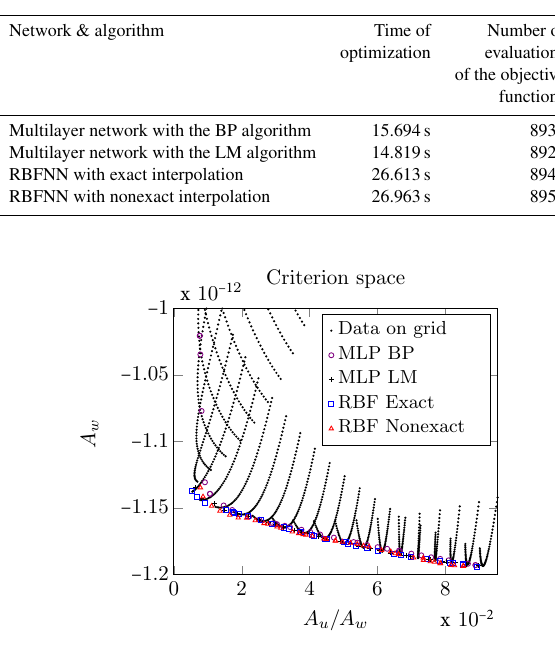
Figure 12. Pareto fronts solved with the MOGA and the neural- network metamodels and scatter plot of the objective function val- ues solved on the discrete grid of the design